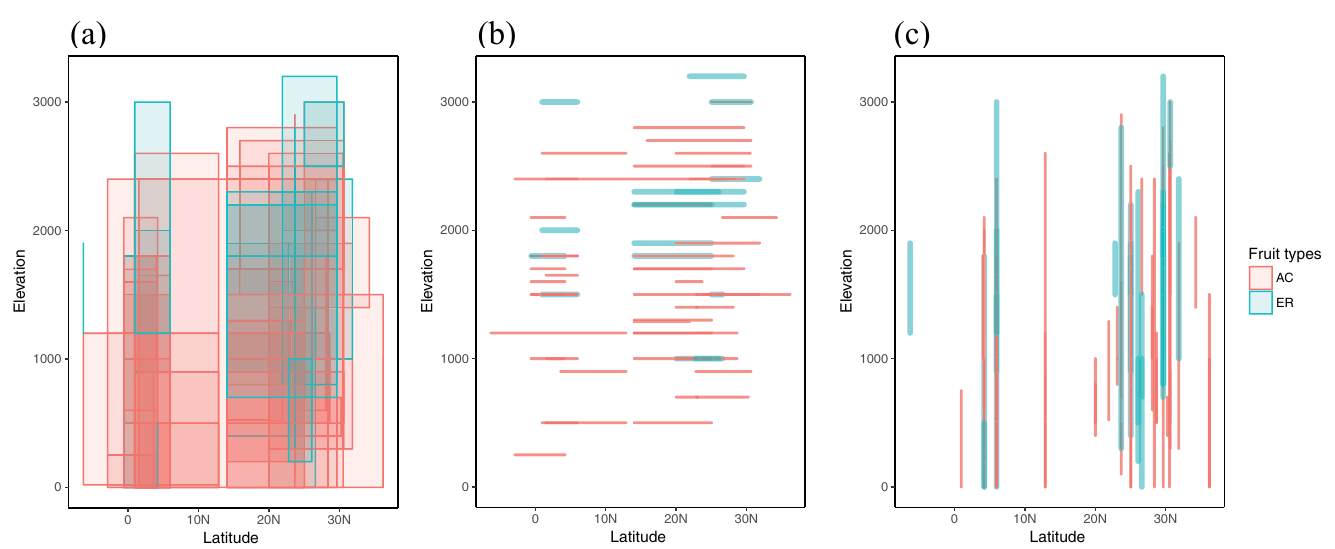
Fig 7. The geographic distribution of 93 Lithocarpus species. (a) Species distribution in altitudinal and latitudinal range. (b) Species distribution in latitudinal range with midpoint elevation. (c) Species distribution in altitudinal range with midpoint latitude. AC and ER stand for acorn and enclosed fruit type respectively.